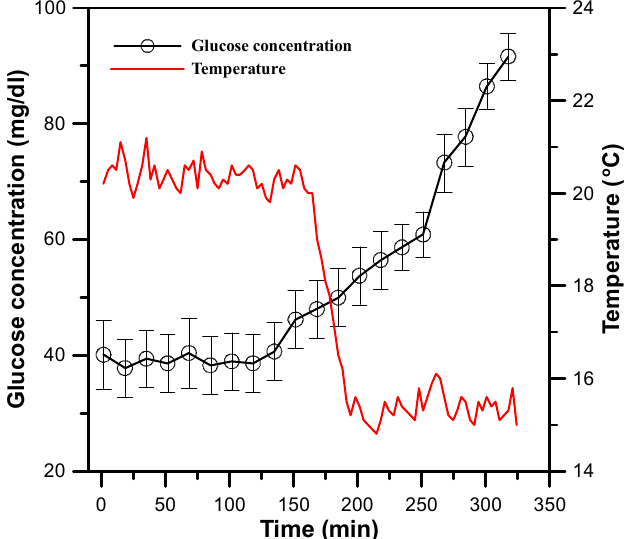
Figure 8. Variation of the glucose concentration of a free-swimming fish (Tilapia) treated with cold shock determined by measuring the blinking frequencies of the SPGB in real time using a smartphone. All experiments were carried out in triplicate.